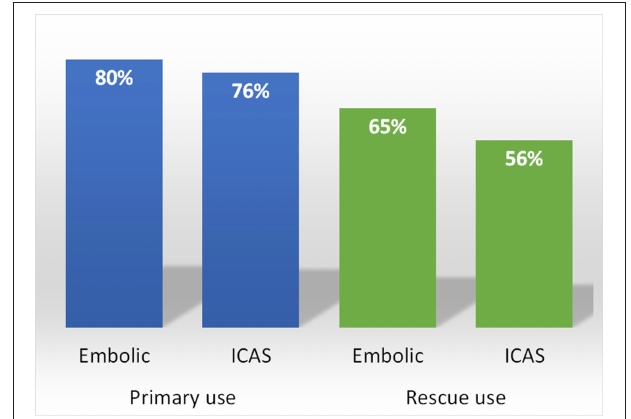
FIGURE 2 | Immediate successful reperfusion rates in embolic and ICAS-related occlusions after Solitaire thrombectomy used as either primary or rescue treatment.